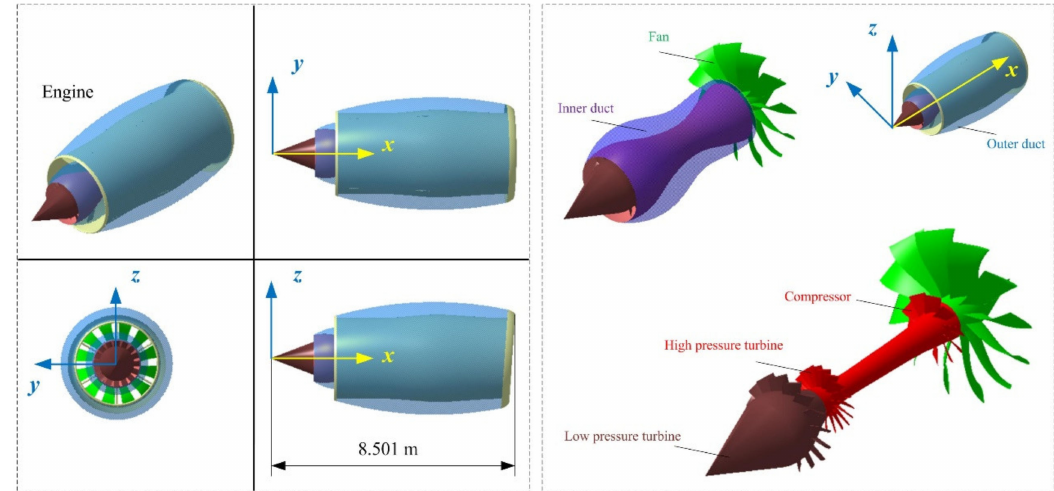
Figure 4. Model building and detail display of the turbofan engine.